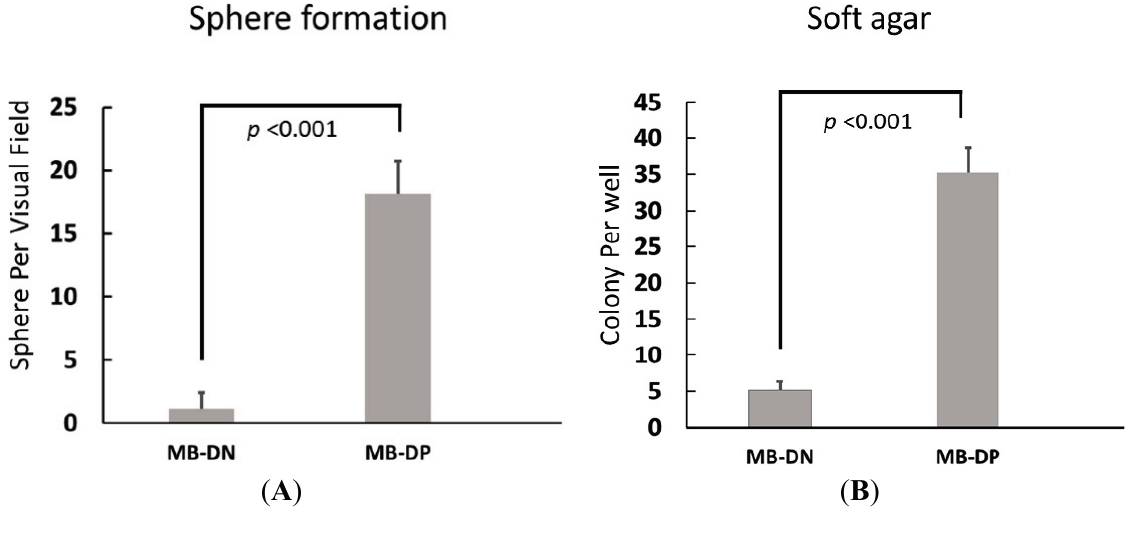
Figure 2. Formation of sphere-like bodies and soft agar colonies by MB-DPs. MB-DPs and MB-DNs from medulloblastoma cell lines Daoy was subjected to sphere formation assays and soft agar colony formation assay. ( A ) Comparison of sphere formation ability between MB-DPs and MB-DNs; and ( B ) Comparison of soft agar colony formation between MB-DPs and MB-DNs: MB-derived CD133/Nestin double-positive cells (MB-DPs); MB-derived CD133/Nestin double-negative cells